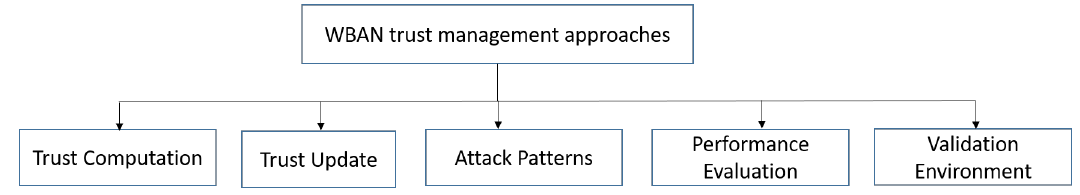
Figure 5. Comparison criteria for WBAN trust management